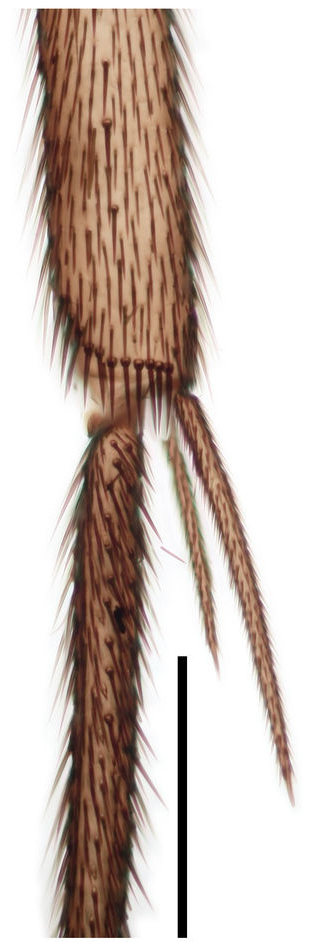
tip of mid tibia